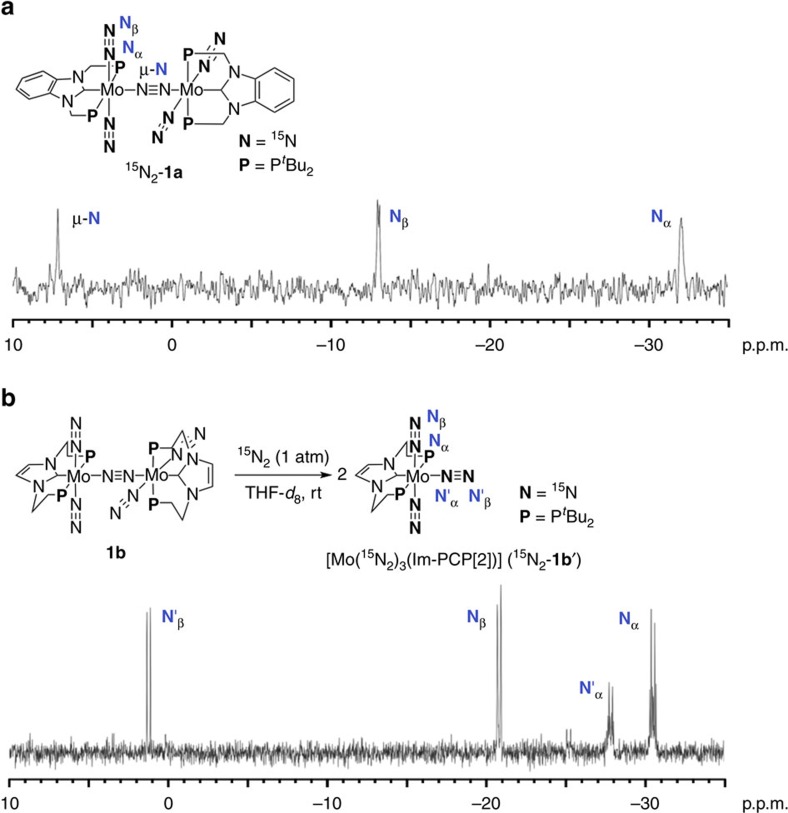
15N{1H} NMR spectra of 1a and 1b.(a) 15N{1H} NMR spectrum of 15N2-1a in C6D6 under 15N2. (b) 15N{1H} NMR spectrum of 15N2-1b′ in THF-d8 under 15N2.